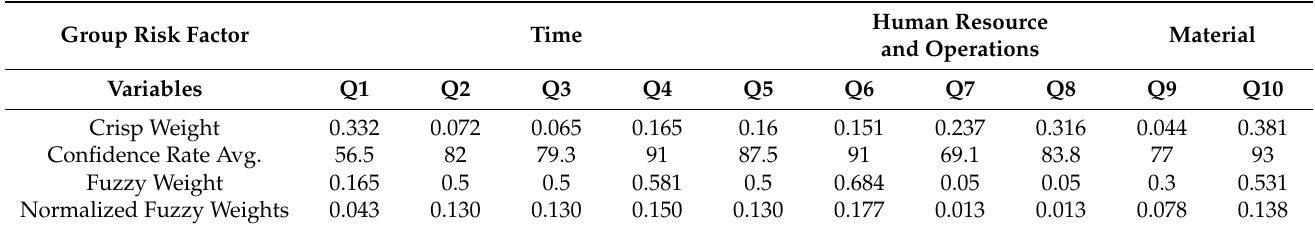
Figure 9 indicates the 3D graphical view of the FIS model, which shows the areas where uncertainty can affect the risk factors.